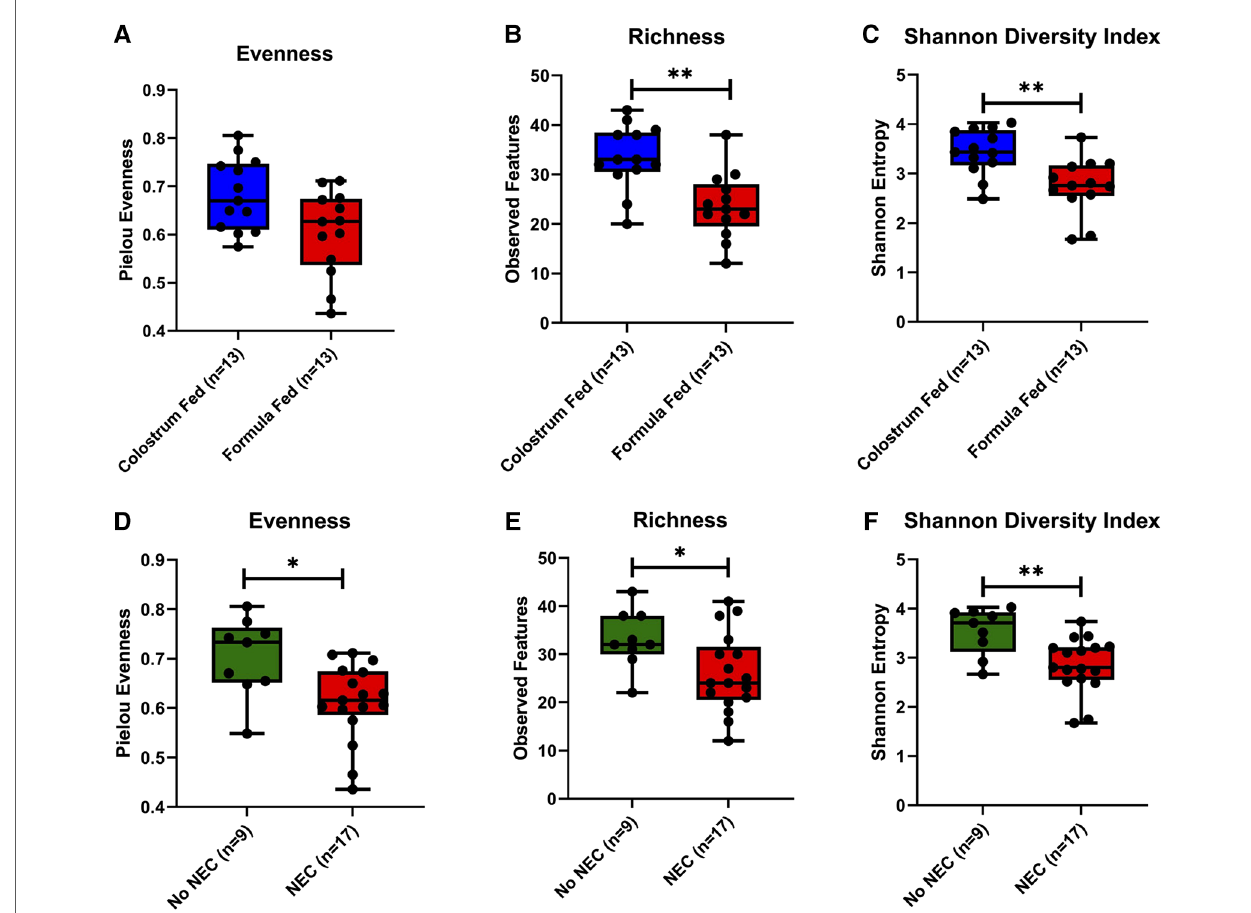
FIGURE 5 Microbial alpha diversity in piglet colonic contents. ( A,D ) Evenness within feeding regimen ( p =0.054) or occurrence of NEC ( p =0.012). ( B,E ) Richness (number of observed features) within feeding regimen ( p =0.002) or occurrence of NEC ( p =0.038). ( C,F ) Shannon Diversity Index within feeding regimen ( p =0.003) or occurrence of NEC ( p =0.006). Pairwise comparisons between groups were made using the Kruskal-Wallis test ( p <0.05). Data are represented as box and whisker plots that denote minimum, maximum, and interquartile range